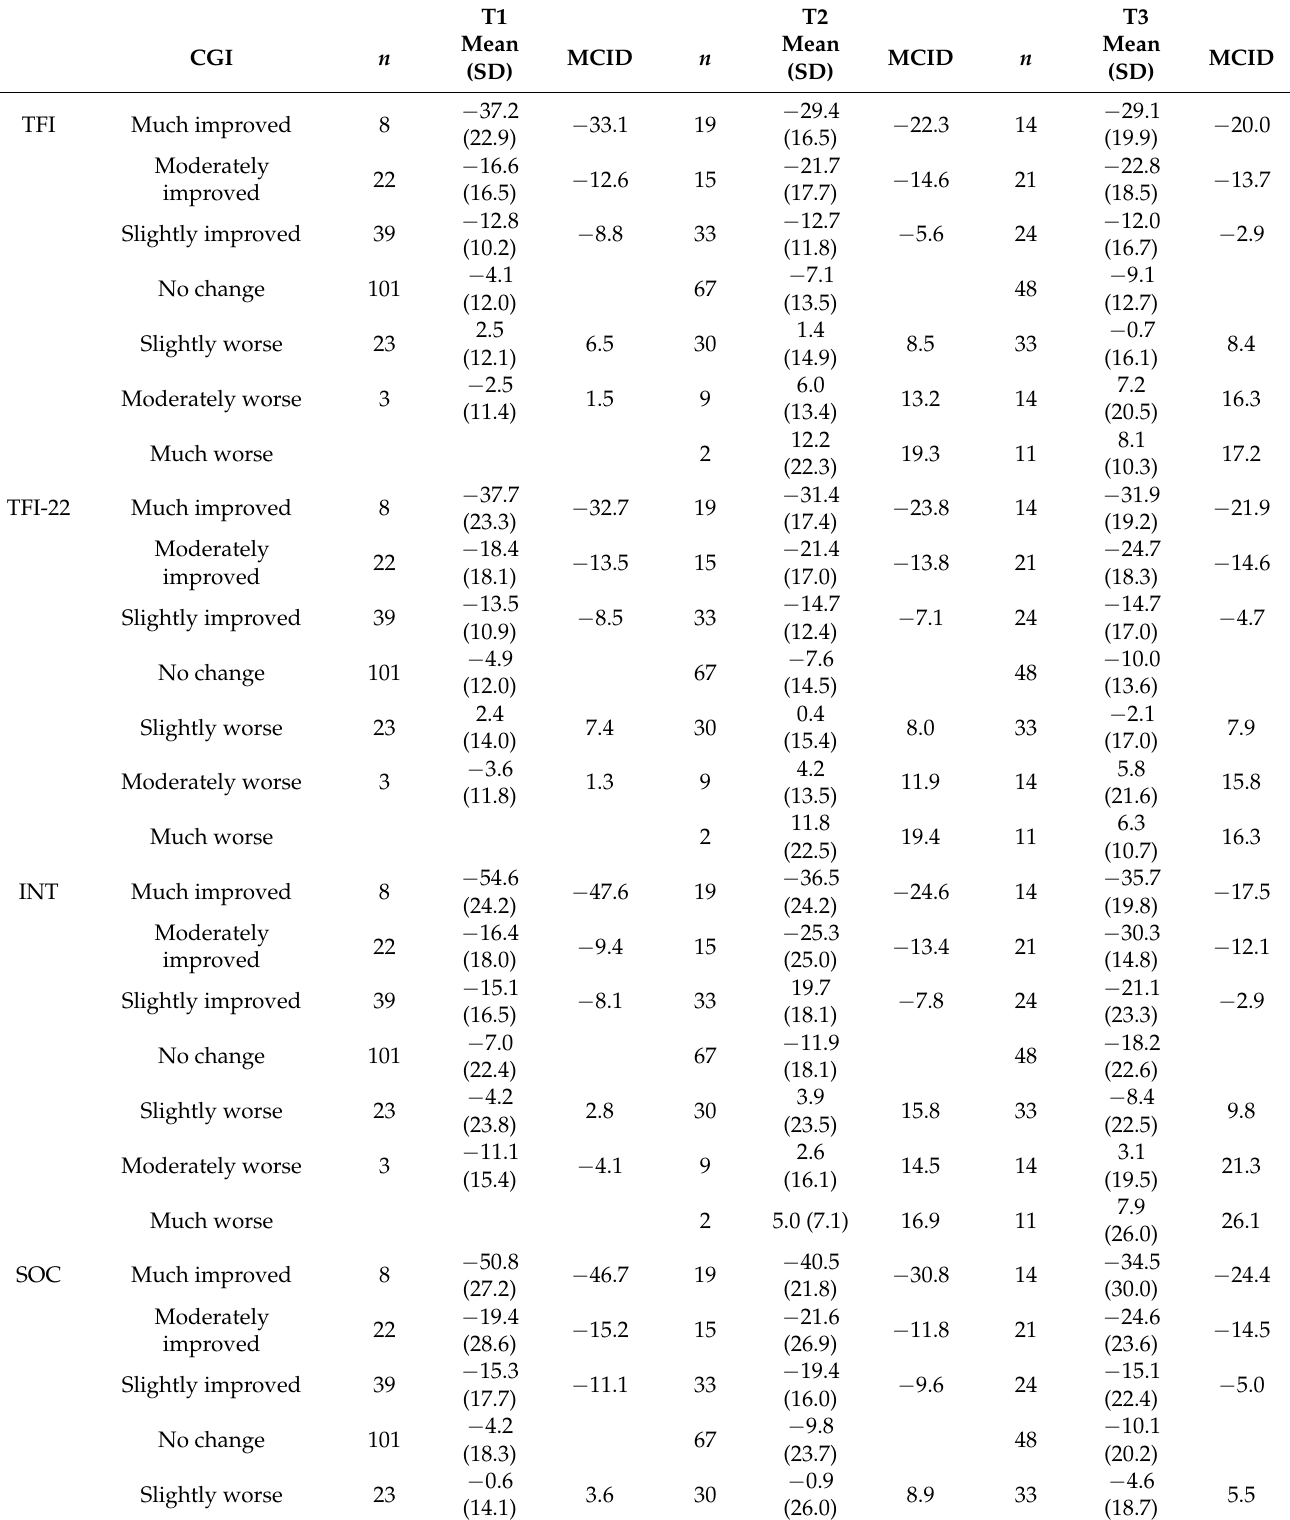
Table 1. Mean (SD) TFI, TFI-22 global and subscale scores according to the Clinical Global Impression (CGI) categories and Minimal Clinically Important Difference (MCID) for ‘improved’ and ‘worsened’ categories for each subscale at follow-up